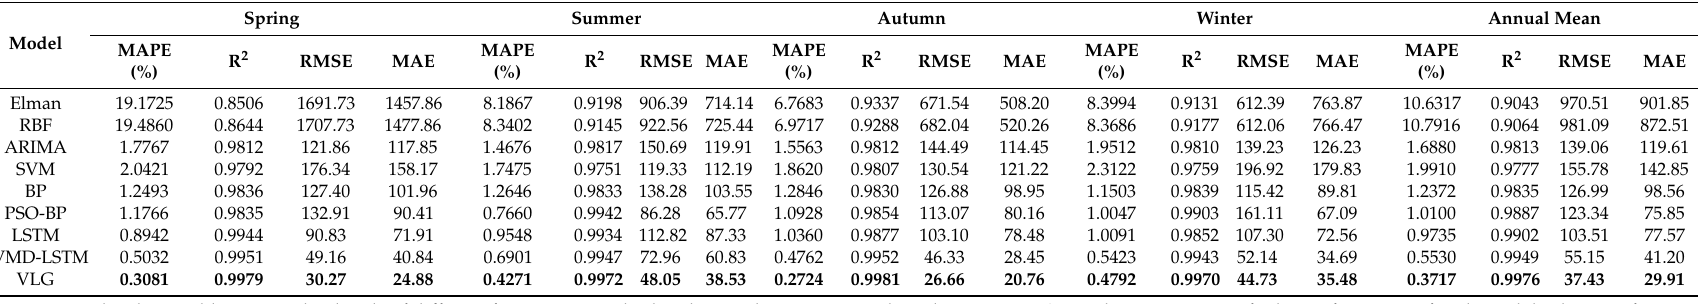
values of this system are superior to those of the other system. Table 9. The performance indicators of the VLG model based on seasonal data from Queensland compared with other traditional power load forecasting methods. Spring Summer Autumn Winter Annual Mean Model Elman